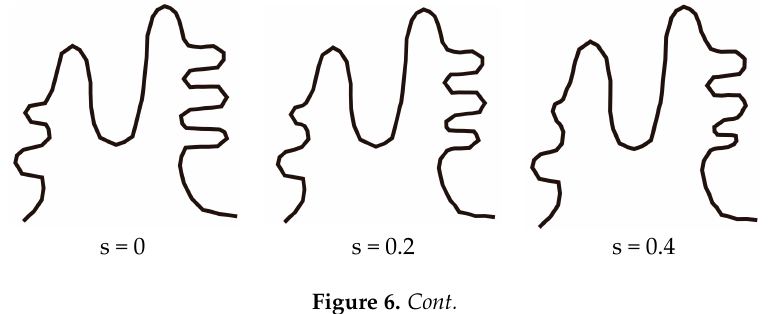
Figure 5. Running time and C tnl values with different annealing speeds w and initial temperatures T 0